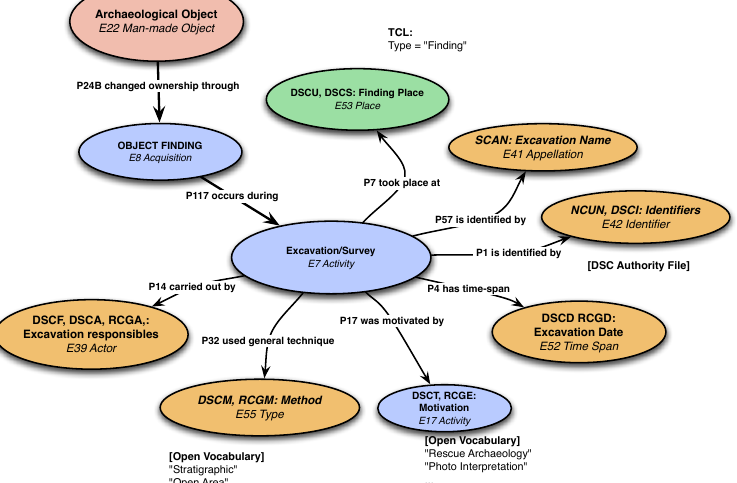
Fig. 2. Mapping schema of the ICCD-RA “Finding”